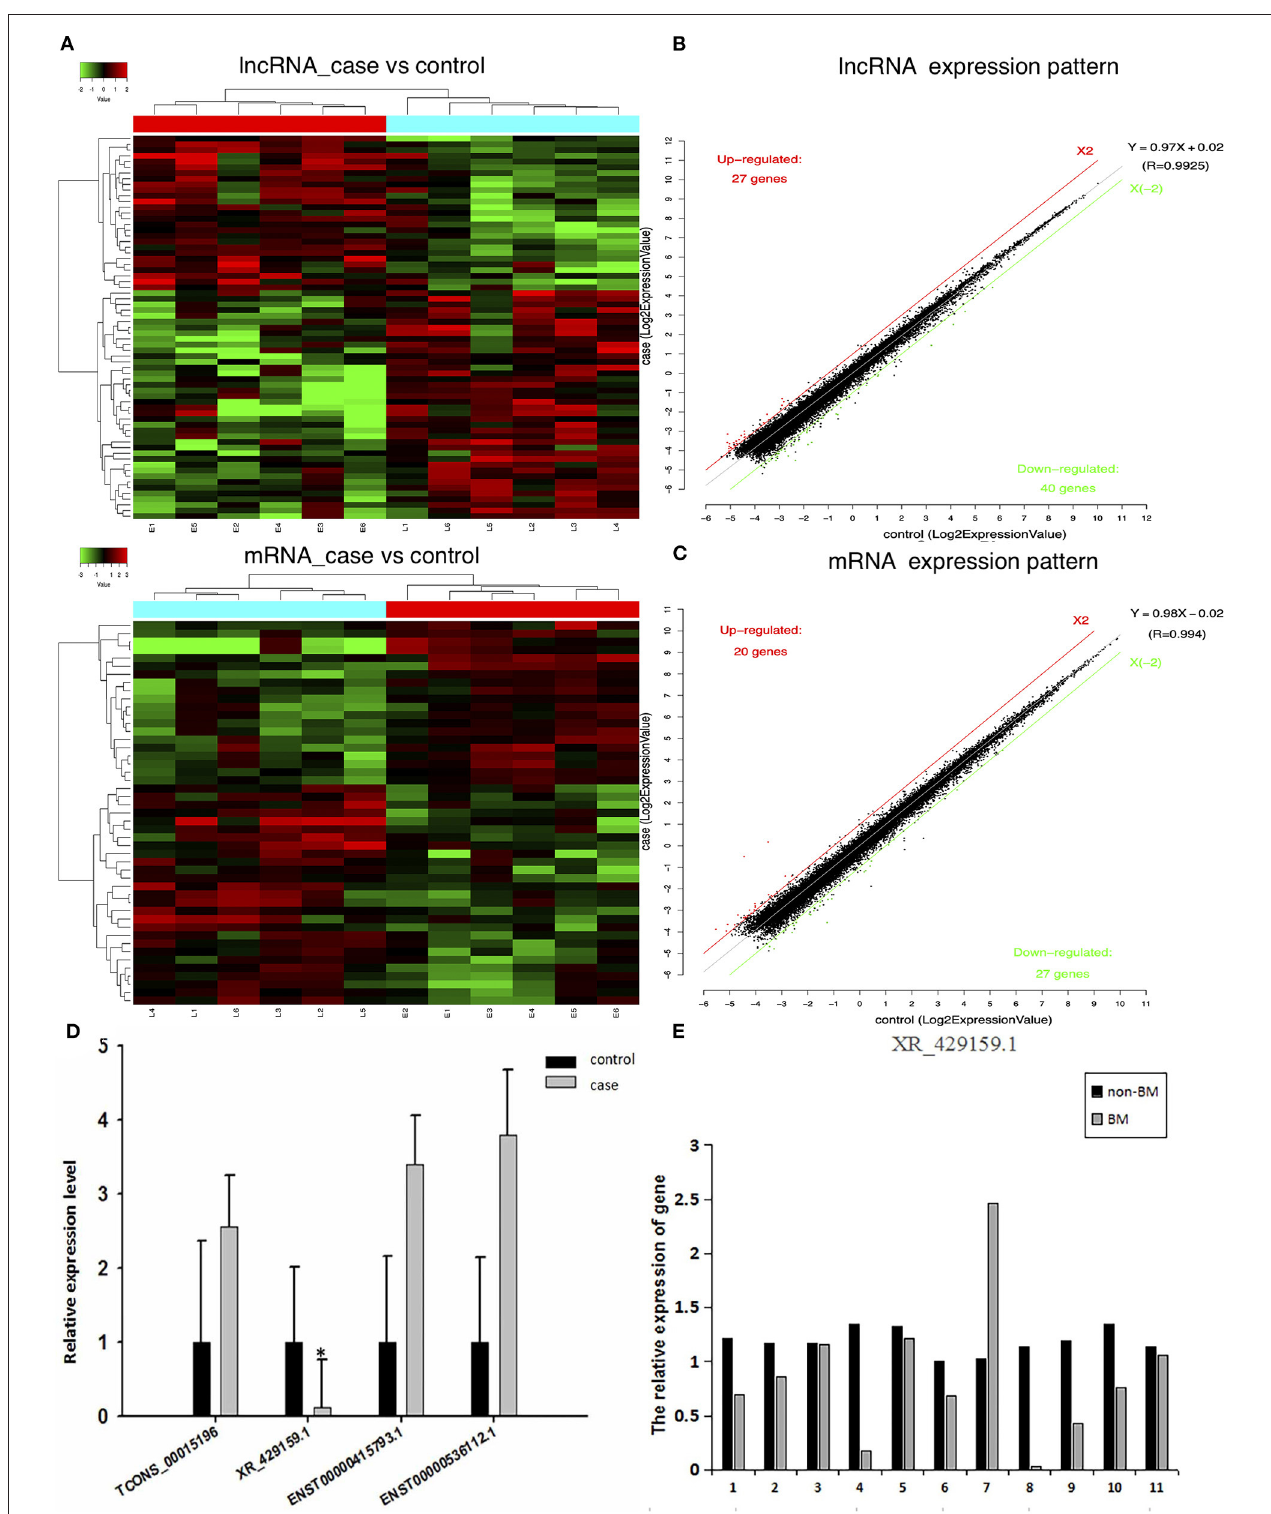
FIGURE 1 | A comprehensive overview of aberrantly expressed lncRNAs and mRNAs in the comparison between BM-SCLC and non-BM-SCLC samples. (A) A total of 67 lncRNAs (27 upregulated and 40 downregulated) and 47 mRNAs (20 upregulated and 27 downregulated) were differentially expressed between BM-SCLC ( n = 6) and SCLC patients without BM ( n = 6). The scatter plot was used to assess lncRNA (B) and mRNA (C) expression patterns between BM-SCLC patients and controls. X-axis: log2 expression value. Y-axis: log2 expression value. Red: upregulated. Green: downregulated. (D) LncRNA expression levels, as determined by microarray and real-time PCR analyses. (E) The comparison between LncRNA XR_429159.1 levels between 11 pairs of patients with and without BM. *p < 0.05.